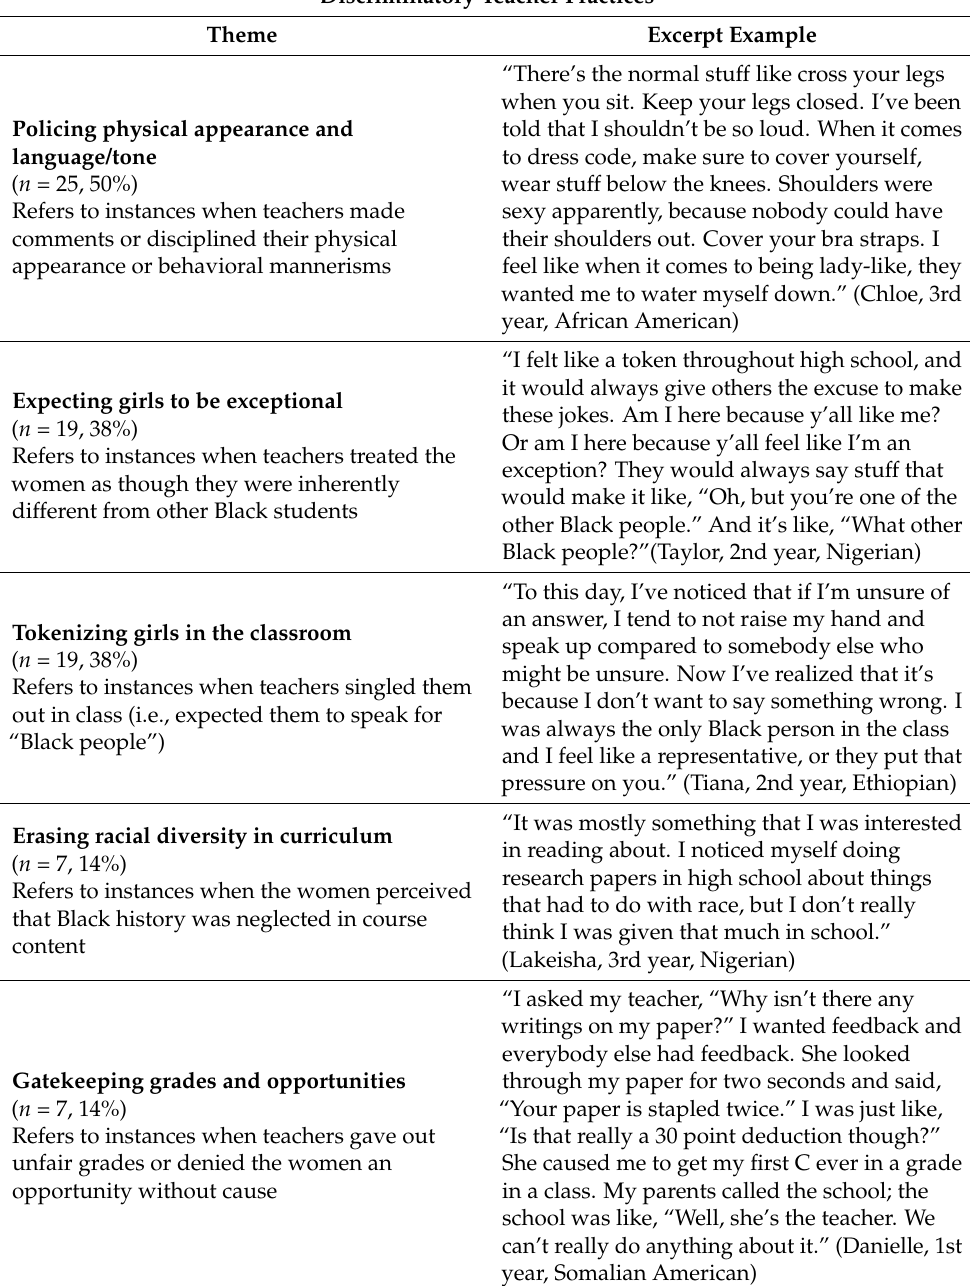
Table 2. Summary of discriminatory teacher